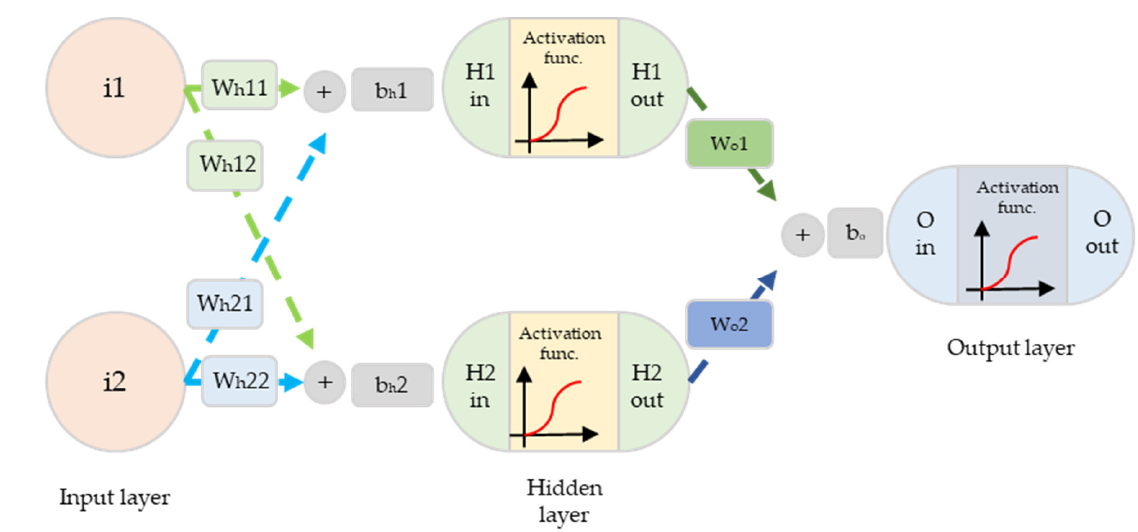
Figure 8. Schematic of artificial neural network.